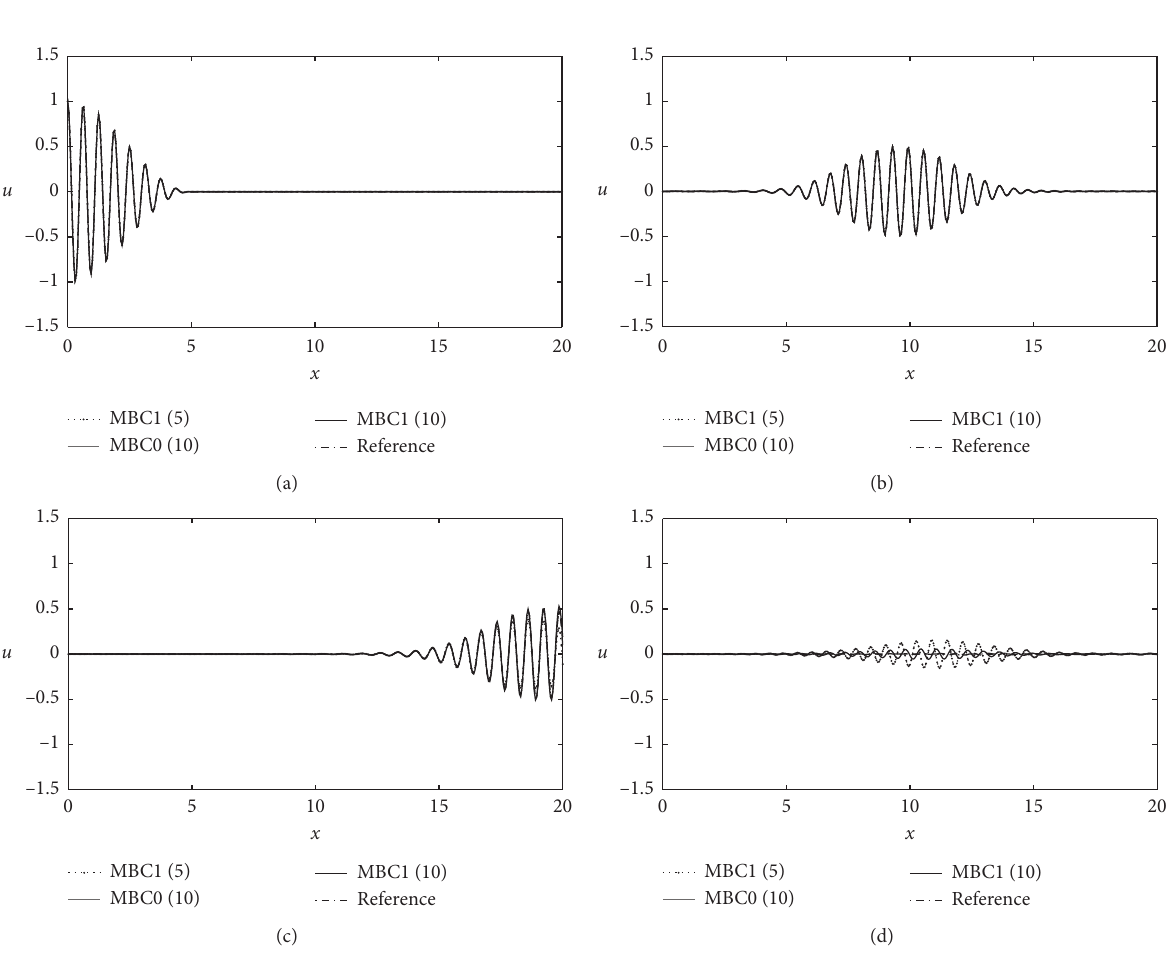
Figure 5: Time evolution of the wave packet with the major wave number ( k ) � 10: (a) t � 0, (b) t � 0.5, (c) t � 1.0, and (d) t �